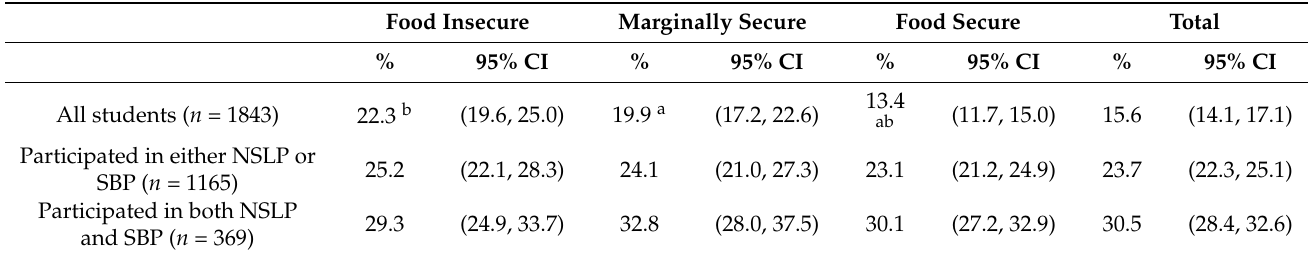
Table 4. Percentage of 24-h energy intakes from NSLP and SBP foods, by food security status 1 .